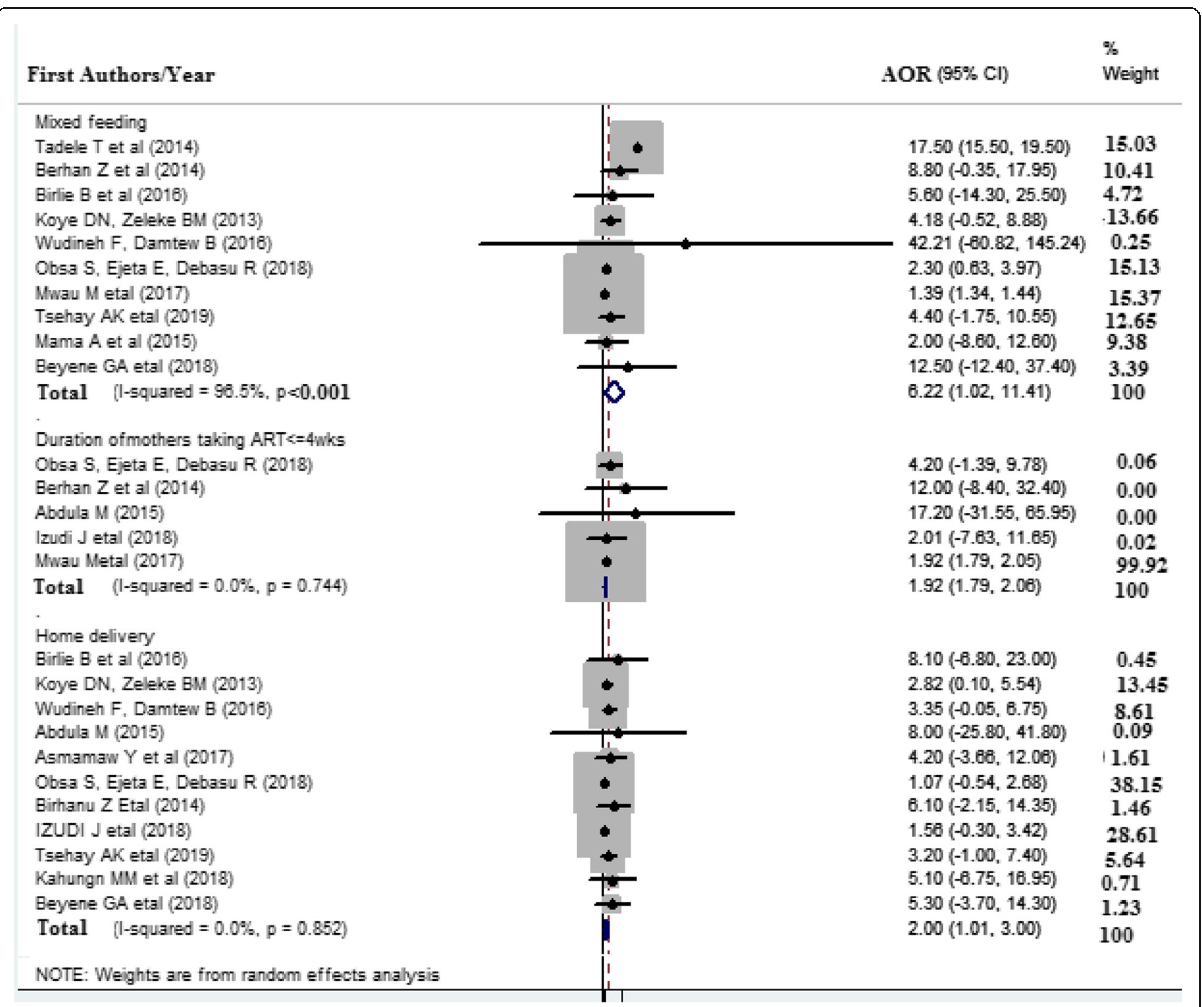
Fig. 4 Forest plot displaying the association of selected factors with vertical HIV infection among exposed infants in East Africa. The midpoint and the length of each segment indicated an AOR and a 95% CI, the arrow showed the widest CI, and the diamond shape showed the combined AOR of all studies for each